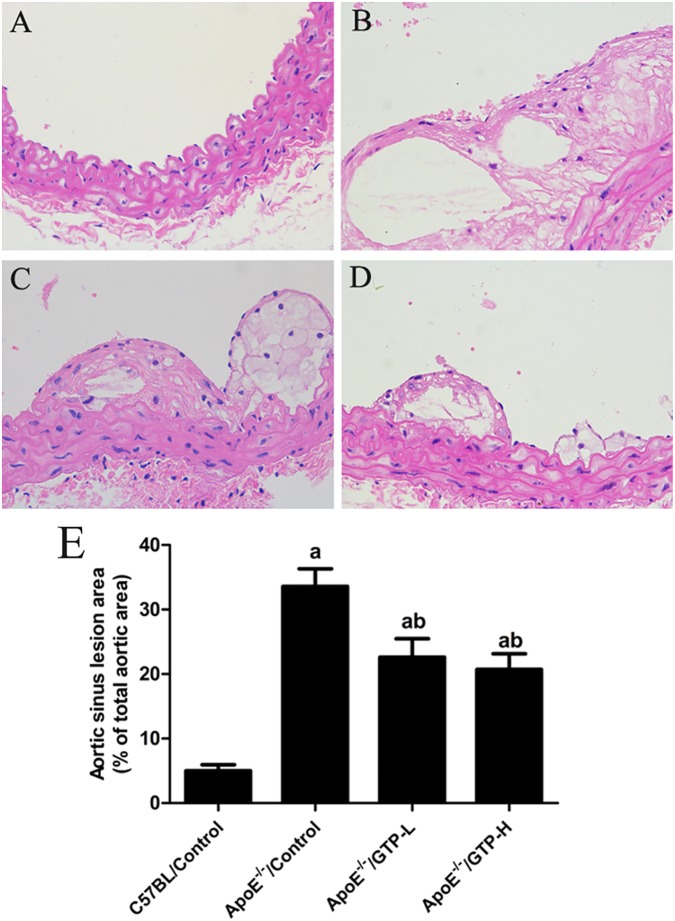
Aortic sinus lesion area of mice in the four groups (n = 3 per group).(A) C57BL/Control; (B) ApoE-/-/Control; (C) ApoE-/-/GTP-L; (D) ApoE-/-/GTP-H (40× magnification), representative aortic sinus sections from mice; (E) Quantitative analysis of the atherosclerotic lesions in aortic sinuses of mice. a
P<0.05 compared to C57BL/Control group; b
P<0.05 compared to ApoE-/-/Control group. Data are expressed as the mean ± SD.